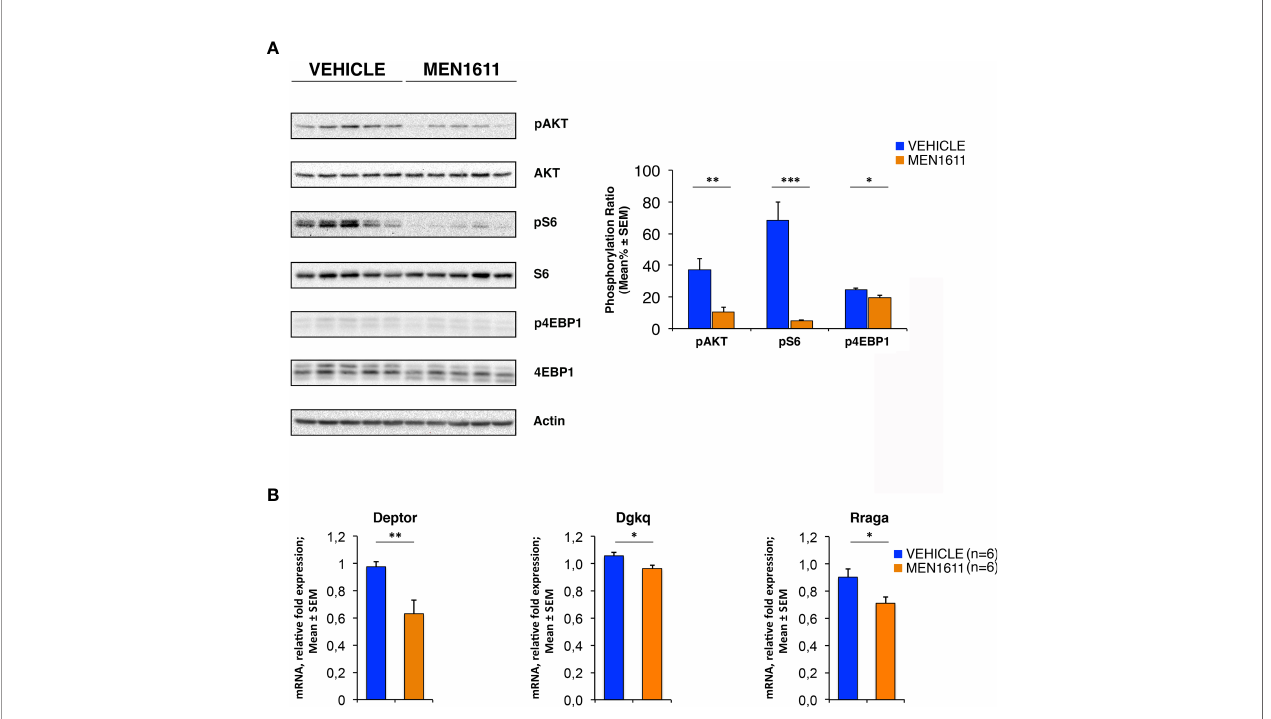
FIGURE 9 | In Ptch1 +/ − /Tis21 KO MB allografts, MEN1611 inhibits the PI3K/AKT/mTOR pathway by down-regulating model-speci fi c genes. (A) Immunoblotting and densitometry analysis with anti-phospho-AKT (at Ser473), anti-AKT, anti-phospho-S6 (at Ser235/236), anti-S6, anti-phospho-4EBP1 (at Thr37/46), and anti-4EBP1 antibodies in MEN1611- and vehicle-treated nodules. Five tumors per treatment were analyzed. The protein phosphorylation ratio (see graph) was obtained by averaging (mean% ± SEM) the band densitometric intensity value of phosphorylated protein versus the densitometric value of total protein of each sample. * p < 0.05, ** p < 0.01 or *** p < 0.001, Student ’ s t test. (B) Real-time PCR analysis of mRNA obtained from MEN1611- and vehicle-treated nodules. Six tumors per treatment were analyzed. Average ± SEM values are from two independent experiments and are shown as fold change relative to the control sample (vehicle-treated nodules; one of them was chosen for set to unit). TBP mRNA was used to normalize data. * p < 0.05 or ** p < 0.01, Student ’ s t